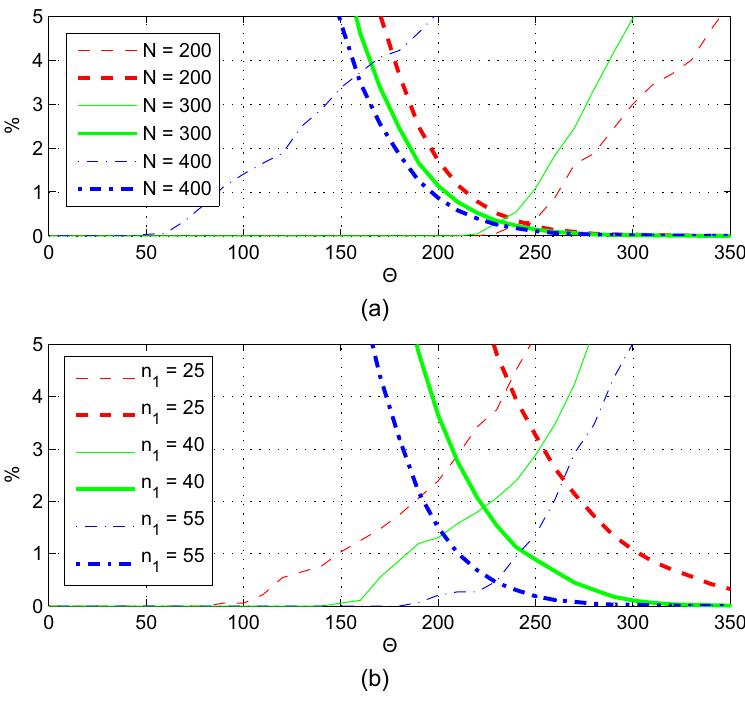
Figure 8. Error rates of BAC, for ( a ) different n thick line: false